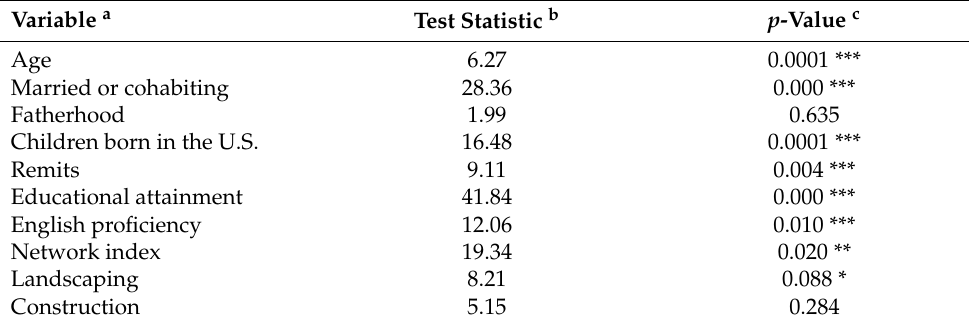
Table 2. Tests comparing subsamples of day laborers by demographic variables of